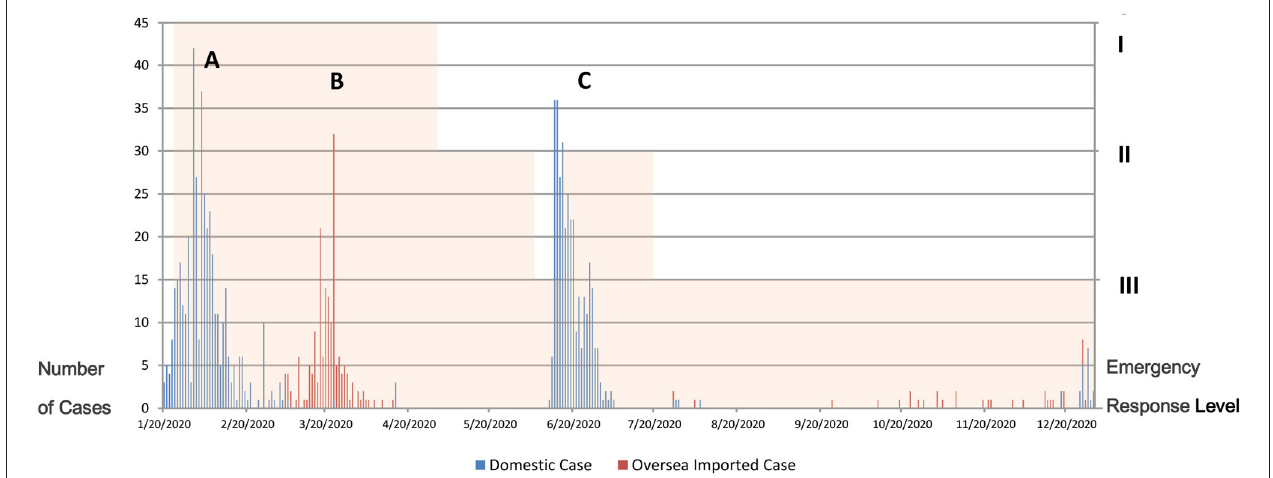
FIGURE 1 | Daily confirmed COVID-19 cases in Beijing from January 20 to December 31, 2020. Peak A (January 20—February 20) was the outbreak of local cases during the Level I emergency response; Peak B (March 5—April 14) was the increase of imported cases during the Level I emergency response; Peak C (June 11—July 5) was the outbreak of local cases at Xinfadi Market from the first Level III emergency response to the second Level II emergency